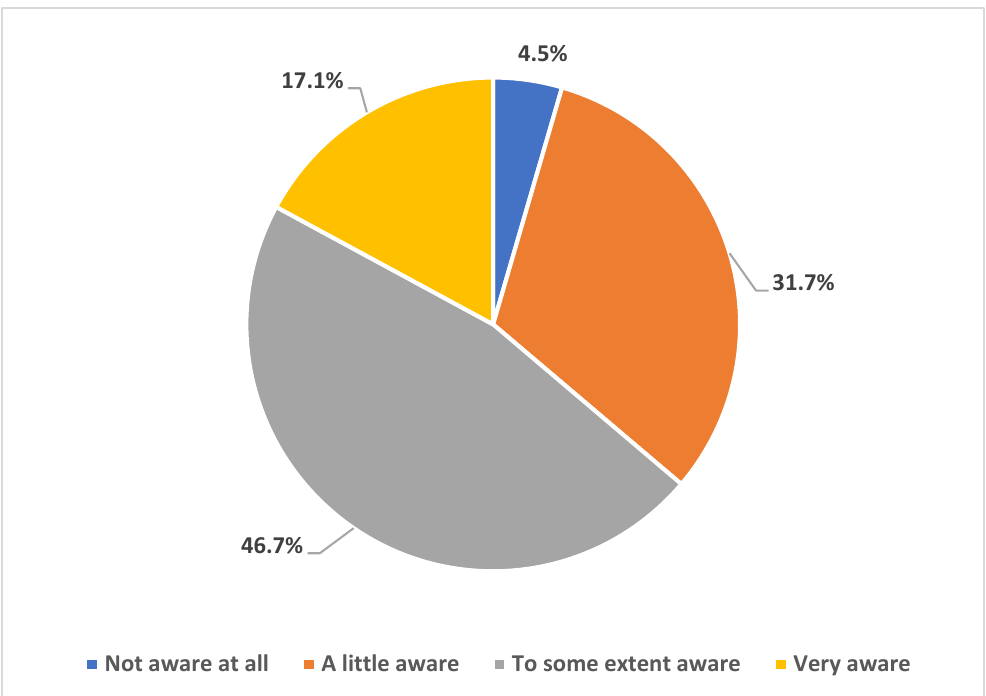
Figure 1. Participants’ awareness of the recent increase in Mpox cases worldwide.